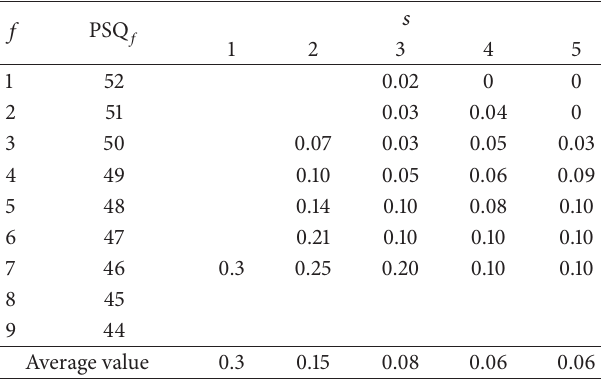
Table 3: The results of differential analysis between TL 𝑓𝑠 and TL (𝑓+1)𝑠